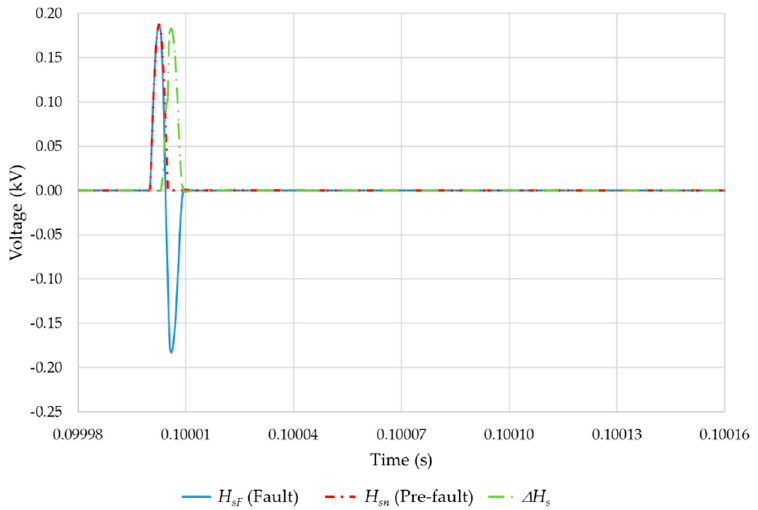
Figure 7. Comparison of a 5 kHz H s in pre-fault condition with the response H sF in fault condition (d = 0.5 km) and the difference ∆𝐻 (cid:3046) .